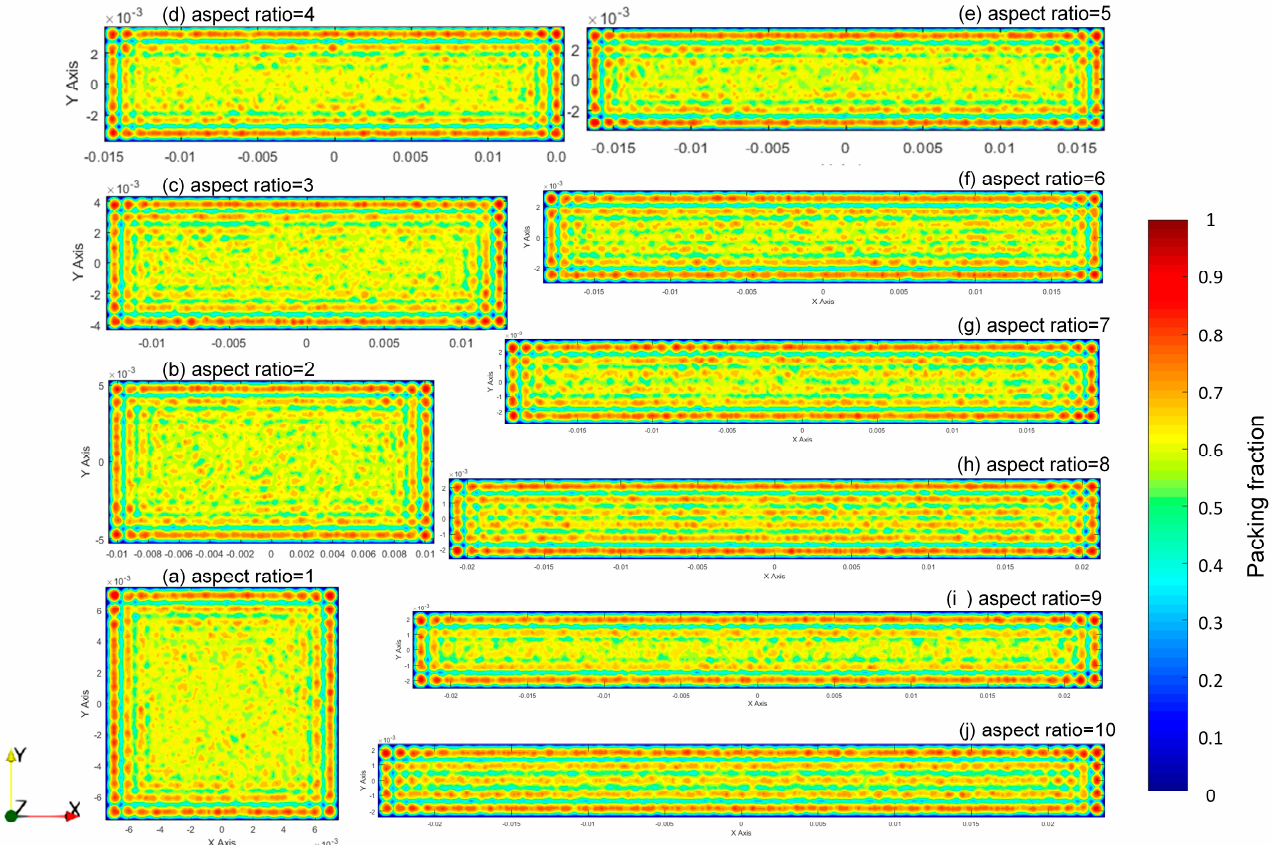
Figure 8. Local packing fraction distribution in the x - y planes of the rectangular pebble beds with a fixed cross-sectional area of 225 d 2 and various aspect ratios of ( a ) 1, ( b ) 2, ( c ) 3, ( d ) 4, ( e ) 5, ( f ) 6, ( g ) 7, ( h ) 8, ( i ) 9, ( j ) 10 (Color online).